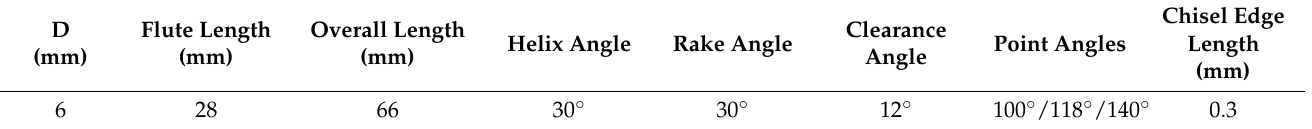
Table 3. Geometries of the cemented carbide